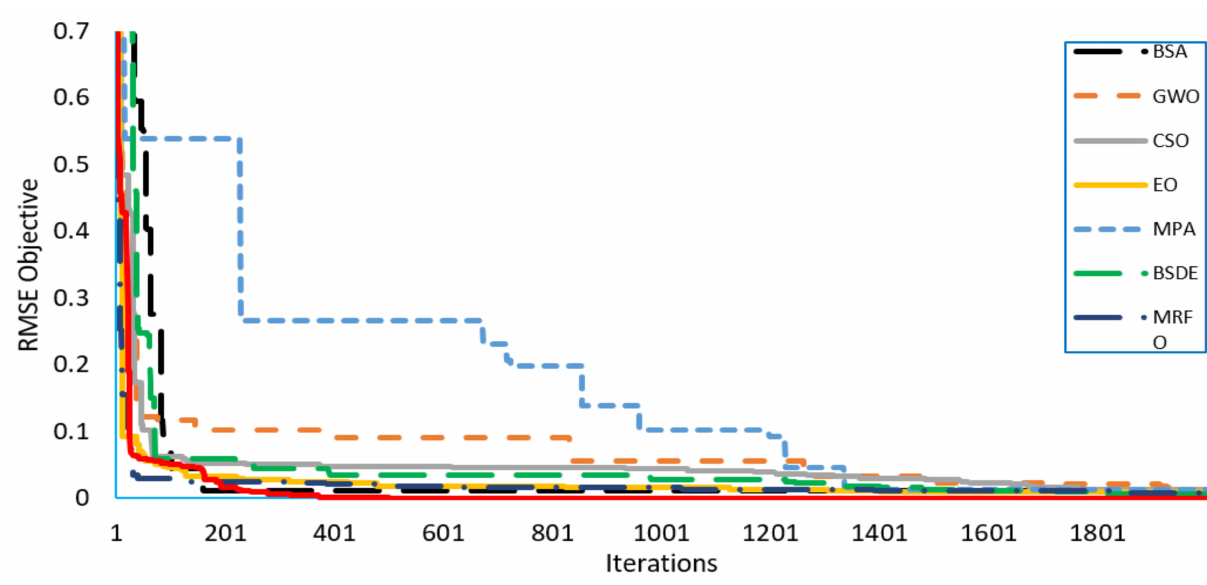
Figure 21. The convergence curves for KC200GT